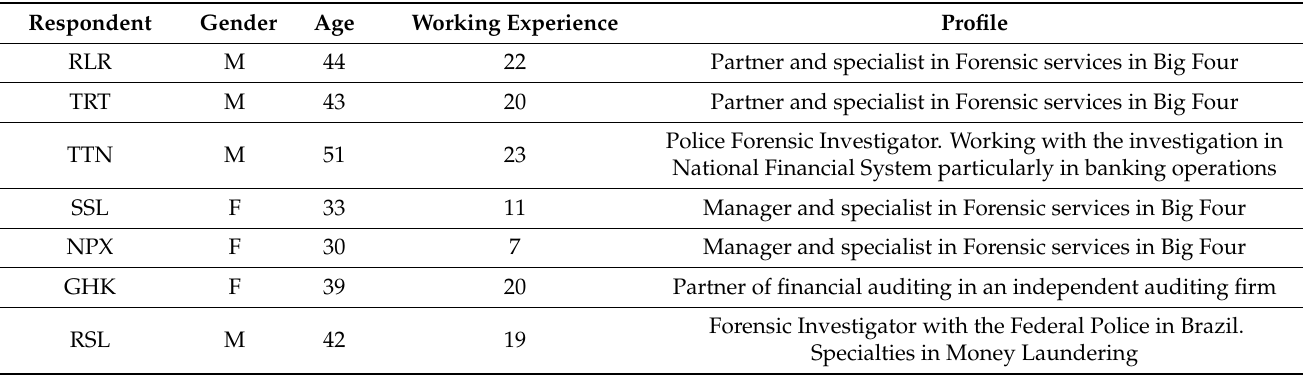
Table 1. Demography of the